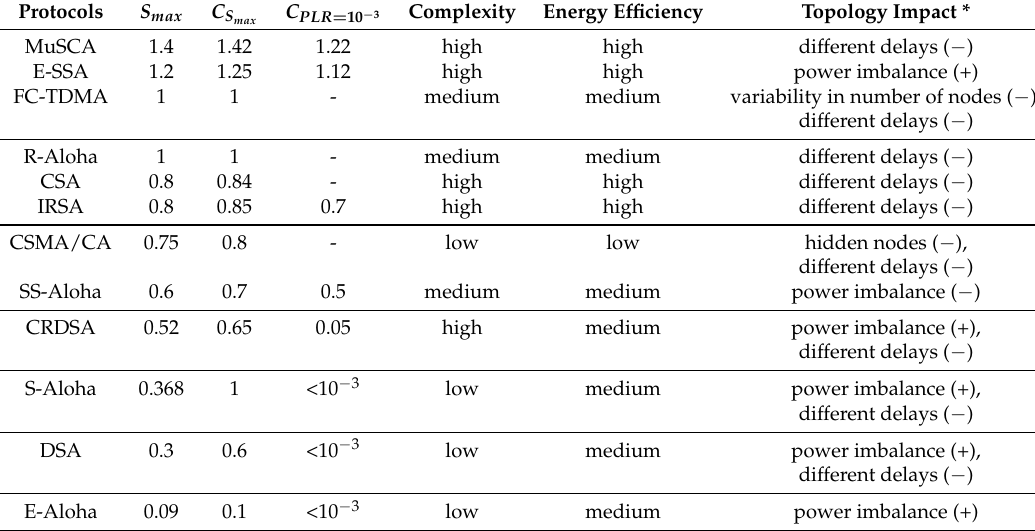
Table 2. Comparison of medium access control (MAC) protocols considering communications performance, complexity of implementation, energy efficiency, and the topology